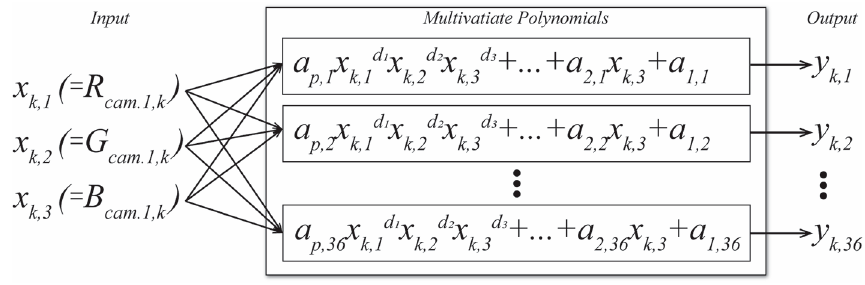
Figure 2. Reflectance reconstruction using polynomial approximation